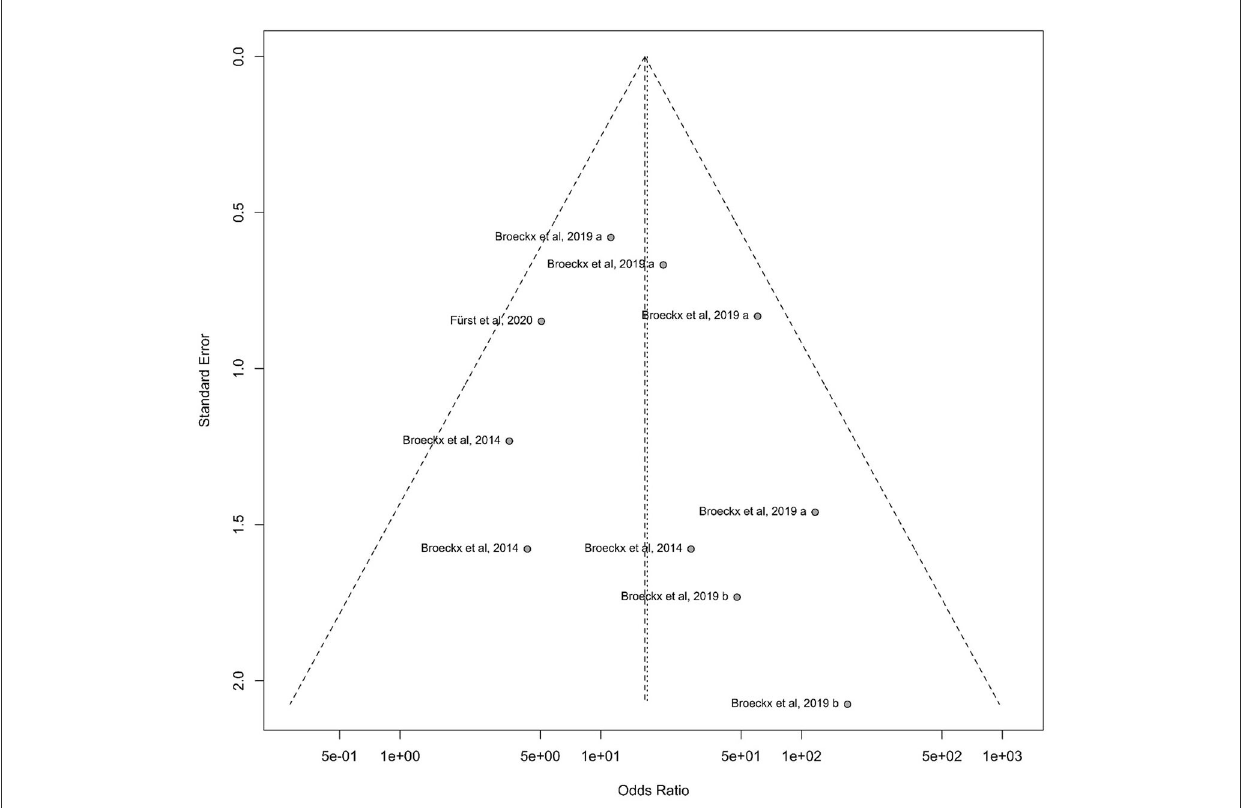
FIGURE7 Funnel diagram demonstrating the standard error to the odds ratio according to the study design of participating horses. On the x-axis, the treatment effect is plotted against the study size on the y-axis. Largest studies are located at the top of the graph and plotted near the average. Smaller studies will spread on both sides of the average and lie close to the